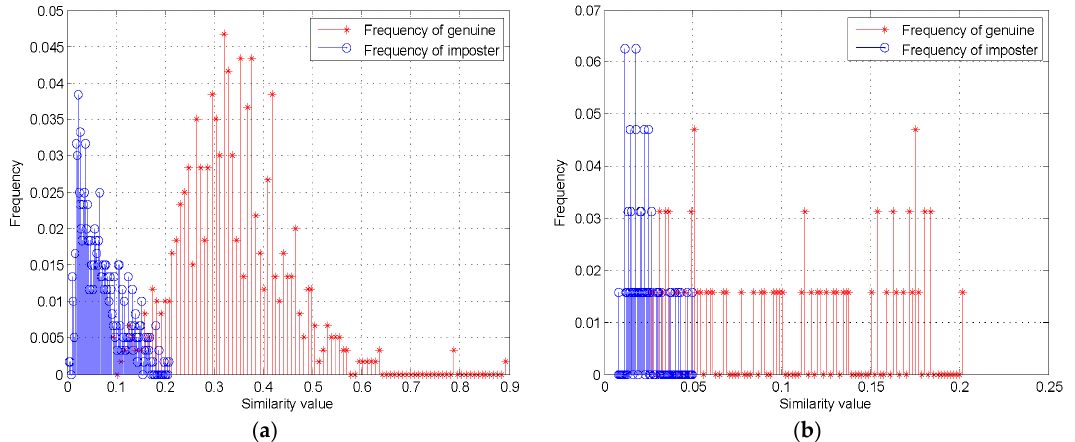
Figure 10. Genuine and imposter distributions of the proposed method on the datasets. ( a ) Results on the MUES-SV1KR2R dataset; ( b ) results on the MUES-SV2HS2S dataset.